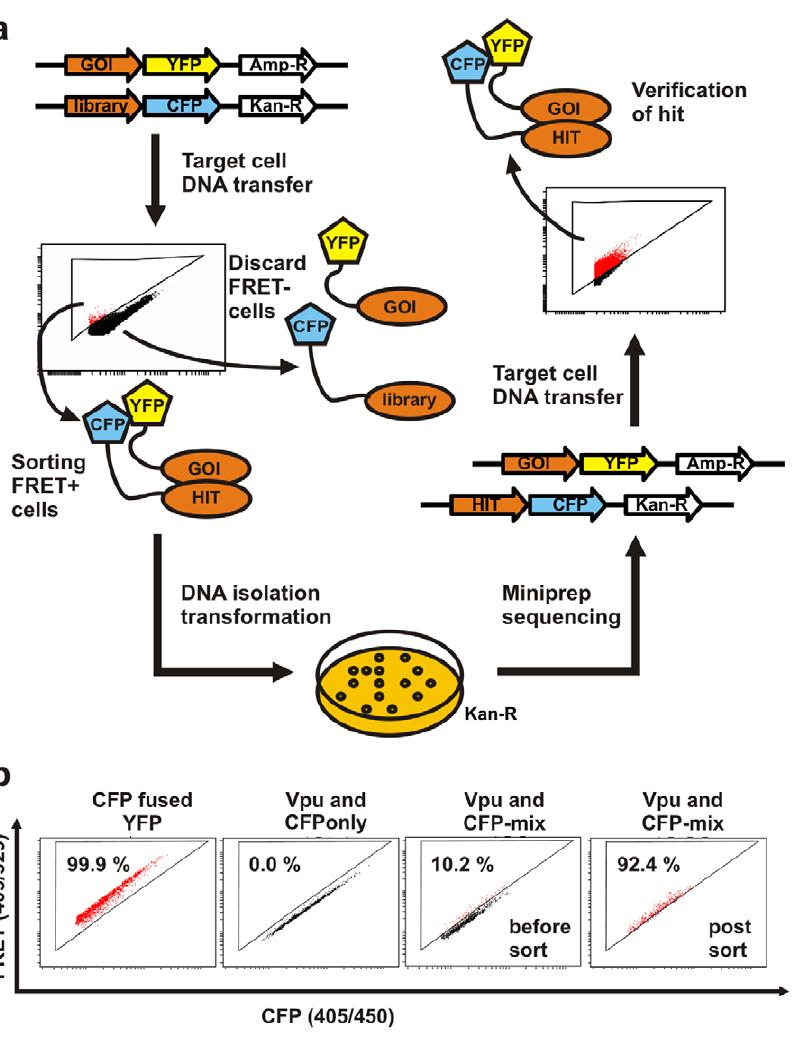
Figure 5. High-throughput-screening for unknown protein interactions by FACS-FRET. (a) Experimental setup to screen for unknown protein interaction with flow cytometry based FRET in high-throughput. (b) Living 293T cells were transfected with the Vpu-YFP fusion as a bait and a mixture of equal amounts of the CFP-fusion constructs that are described in Figure 2. 36 h post transfection FRET + cells were sorted, pelleted, resuspended in PBS and reanalysed for successful purification. Abbreviation GOI, gene of